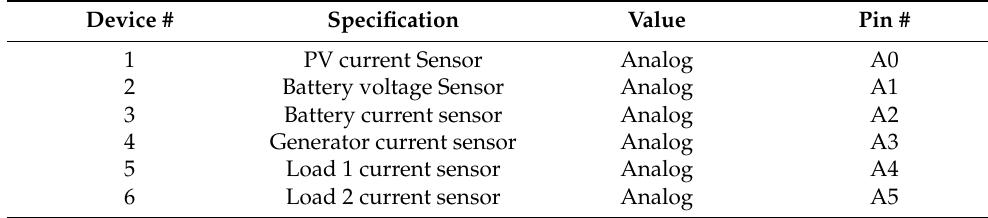
Table 7. The Wio terminal interconnections with